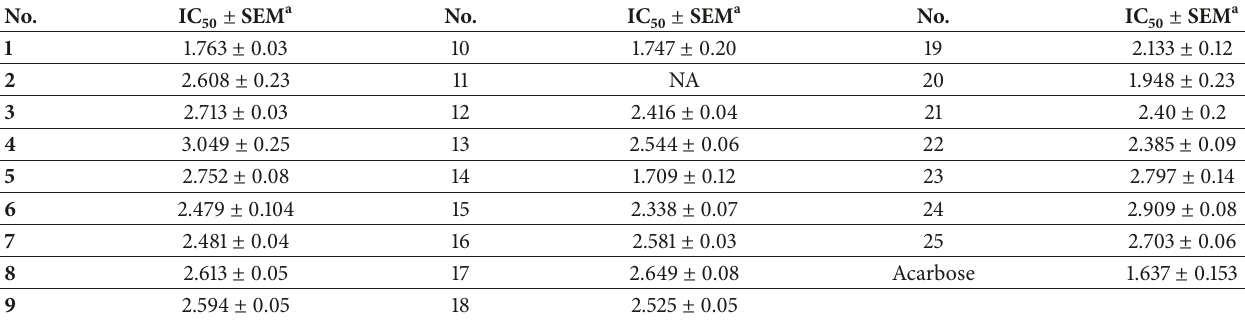
Table 2: 𝛼 -Amylase inhibitory potential of thiazole based carbohydrazides.